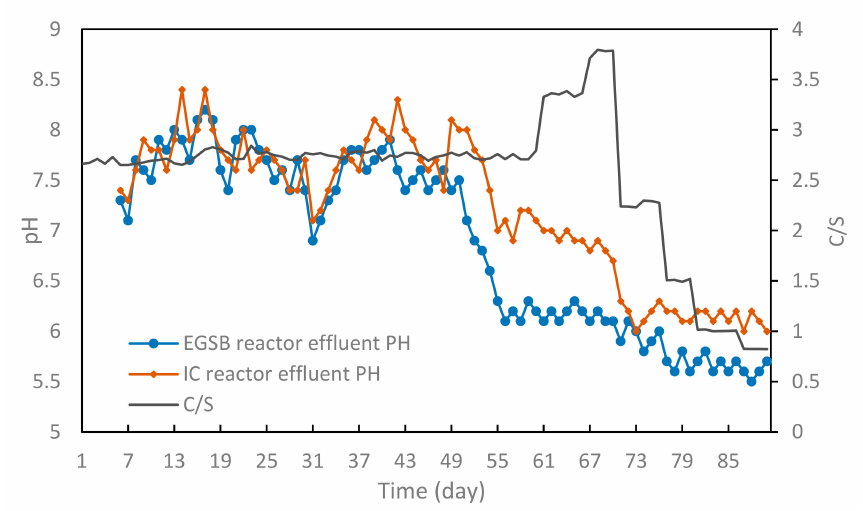
Figure 7. pH changes of reactor effluent.